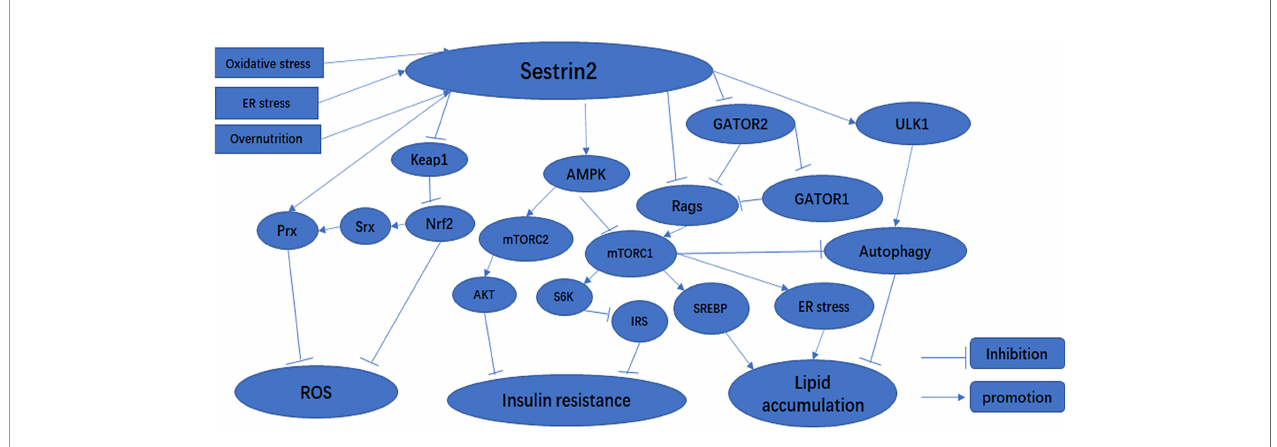
FIGURE 1 | The effect of Sestrin2 on metabolic-related